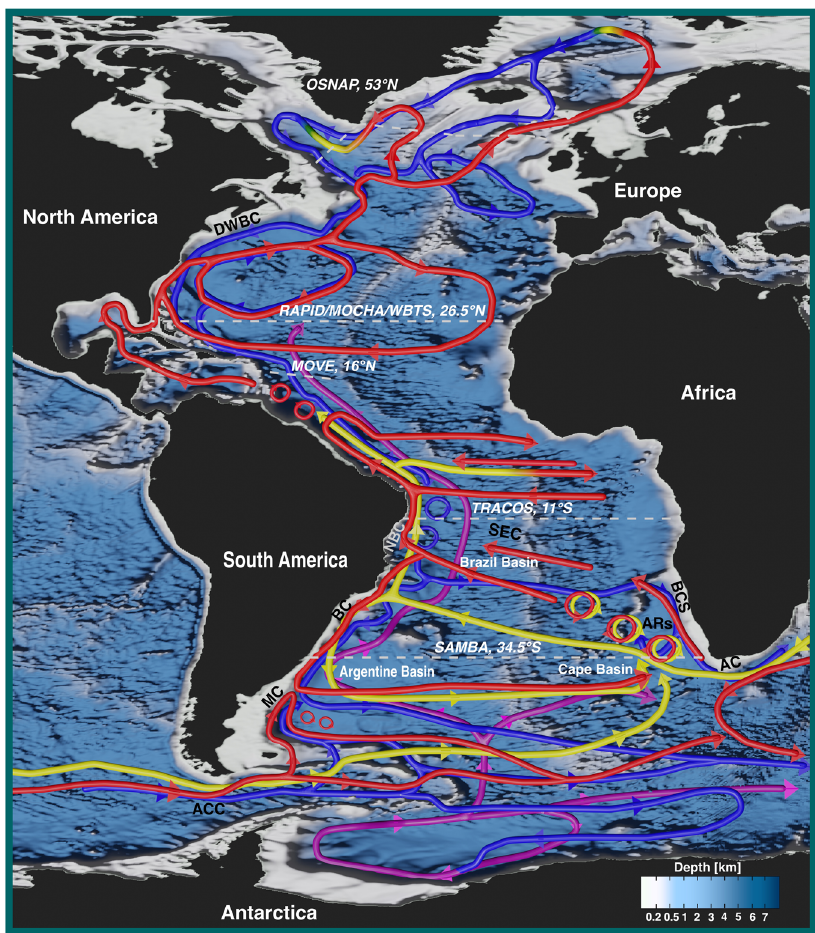
Fig. 1 Idealized schematic of the overturning circulation in the Atlantic Ocean. The schematic represents the pathways of surface (red), intermediate (yellow), deep (blue), and abyssal (purple) waters over the bottom topography (blue shading). Transitions between these colors indicate water mass transformations. Important currents and topographic features mentioned in the text are labeled, and dashed white lines indicate the nominal latitudes of the fi ve Atlantic Meridional Overturning Circulation (AMOC) monitoring arrays (Box 1). AC Agulhas Current, ACC Antarctic Circumpolar Current, ARs Agulhas Rings, BC Brazil Current, BCS Benguela Current System, DWBC Deep Western Boundary Current, MC Malvinas Current, NBC North Brazil Current, SEC South Equatorial